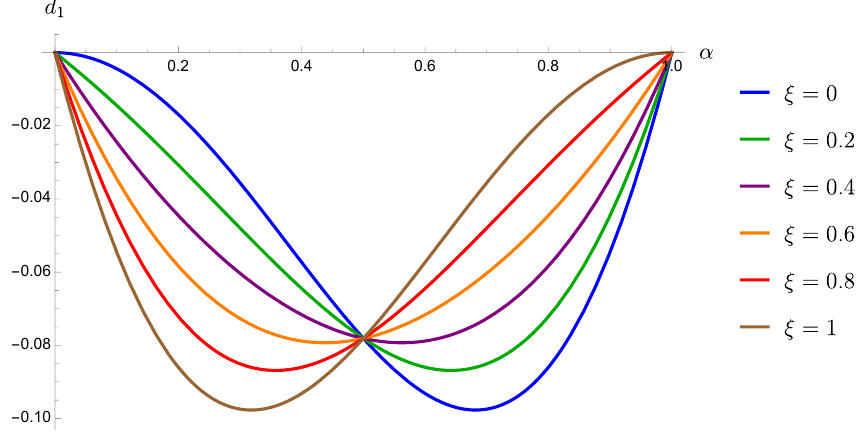
Figure 3 . Behavior of d 1 as a function of α for a monodromy defect in a theory of a single free Dirac fermion in d = 6 for various values of ξ , from eq. (5.21). Note that when α = 1 / 2 , d 1 is independent of ξ